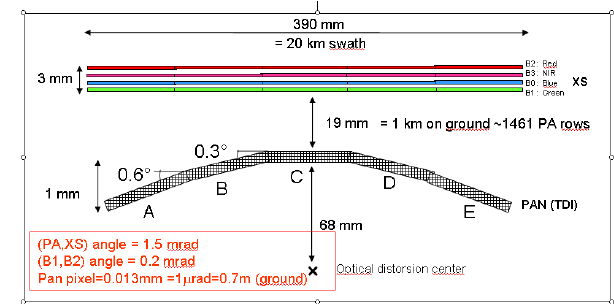
Figure 9: viewing directions measurement using cross acquisition